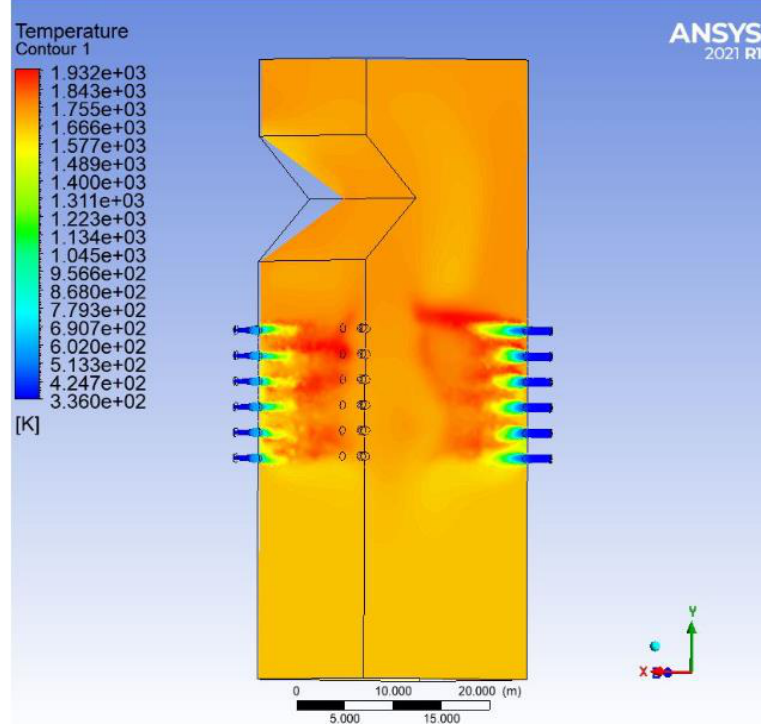
Figure 12. Temperature distribution of flue gas in case-VI.